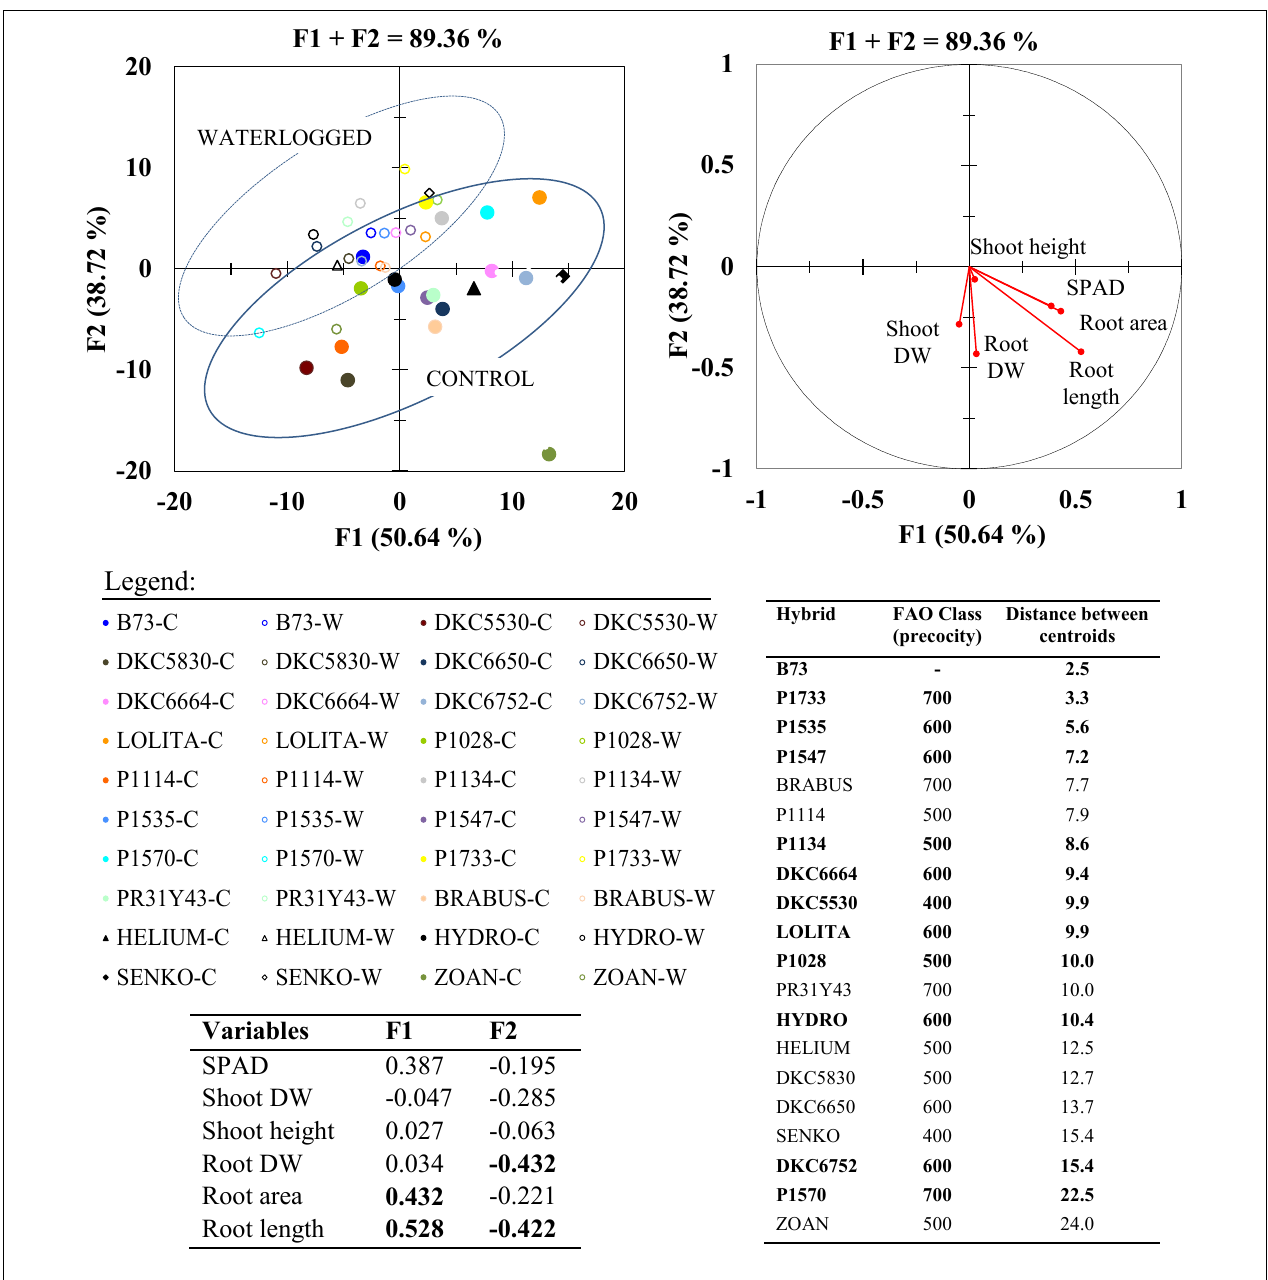
FIGURE 5 | Principal component analysis (PCA; top right) for morphological shoot and root parameters with highly informative variables (loadings > | 0.4| ) in bold within synthetic variables F1 and F2 (bottom left Table); and multigroup discriminant analysis (MDA; top left) of waterlogged (W) and control (C) plants of commercial hybrids and the inbred line B73 at 17 DAS. Distances between centroids for each hybrid (waterlogged vs. control) in MDA (bottom right Table) are reported in ascending order, with highlighted hybrids (bold) considered for the subsequent molecular